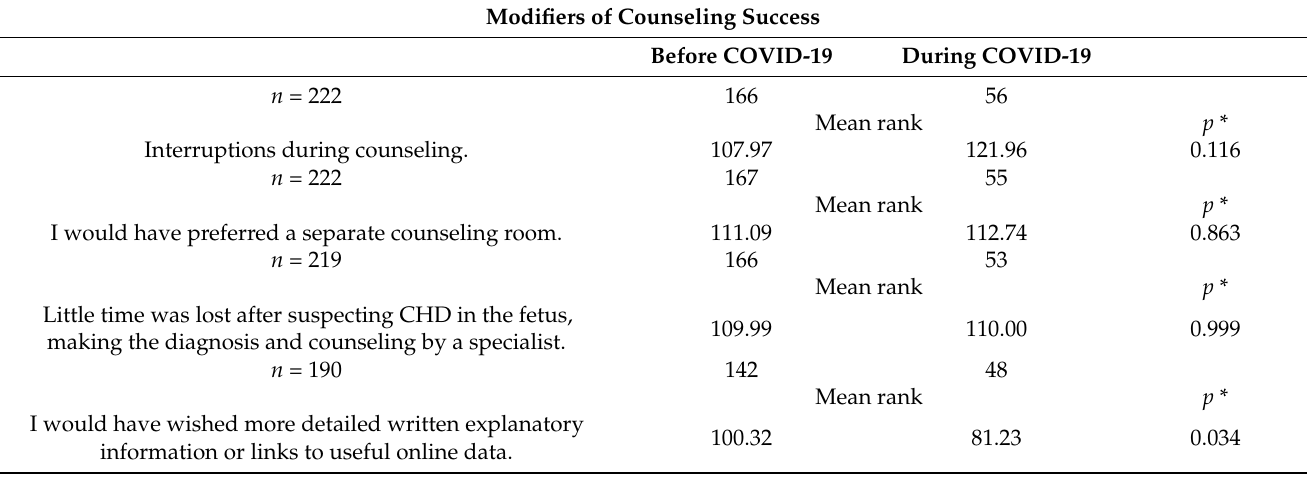
Table 3. Differences between parents counseled before and during the pandemic with regard to different modifiers of counseling success (* Mann Whitney-U